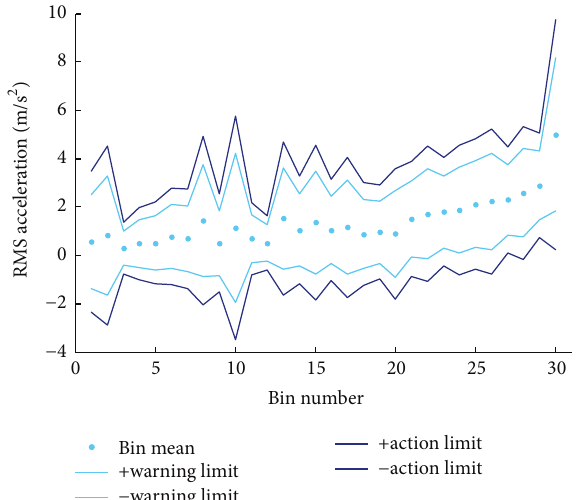
Figure 19: Monitoring using a 3-month established